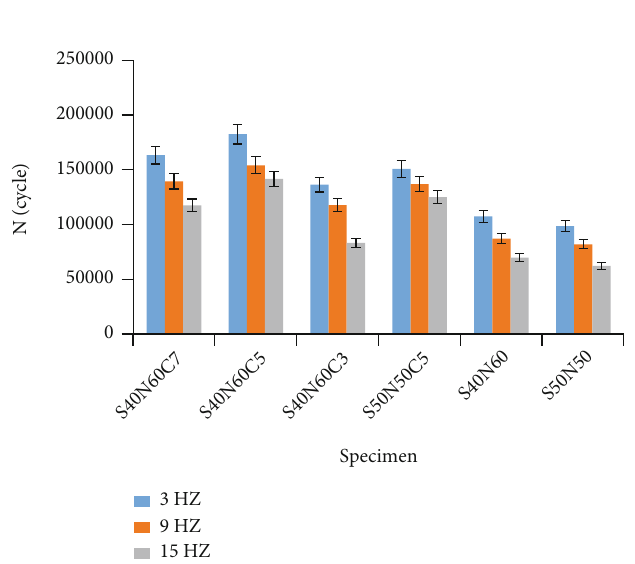
Figure 8: Fatigue life changes of di ff erent samples at 50% strain and at frequencies of 3 Hz, 9Hz, and